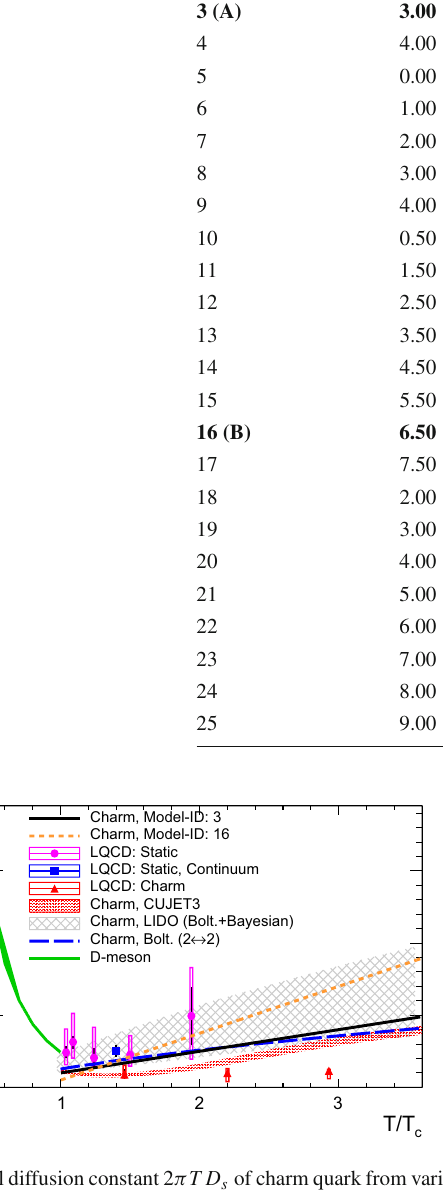
Table 1 Summary of the adjustable parameters in Eq. (10), together with the relevant χ 2 / d . o . f obtained for